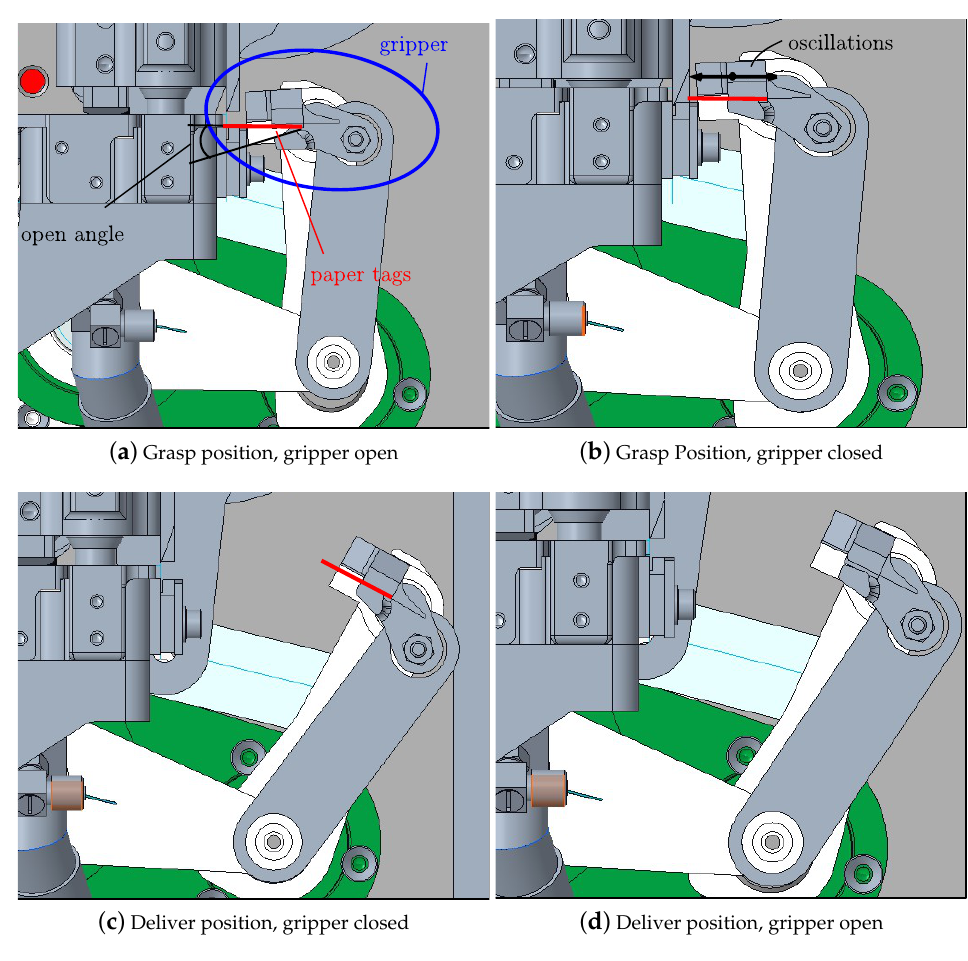
Figure 2. ( a ) Gripper position where the paper tags are received, ( b ) experimentally-identified direction of oscillation, ( c ) deliver position, ( d ) deliver position with paper tag